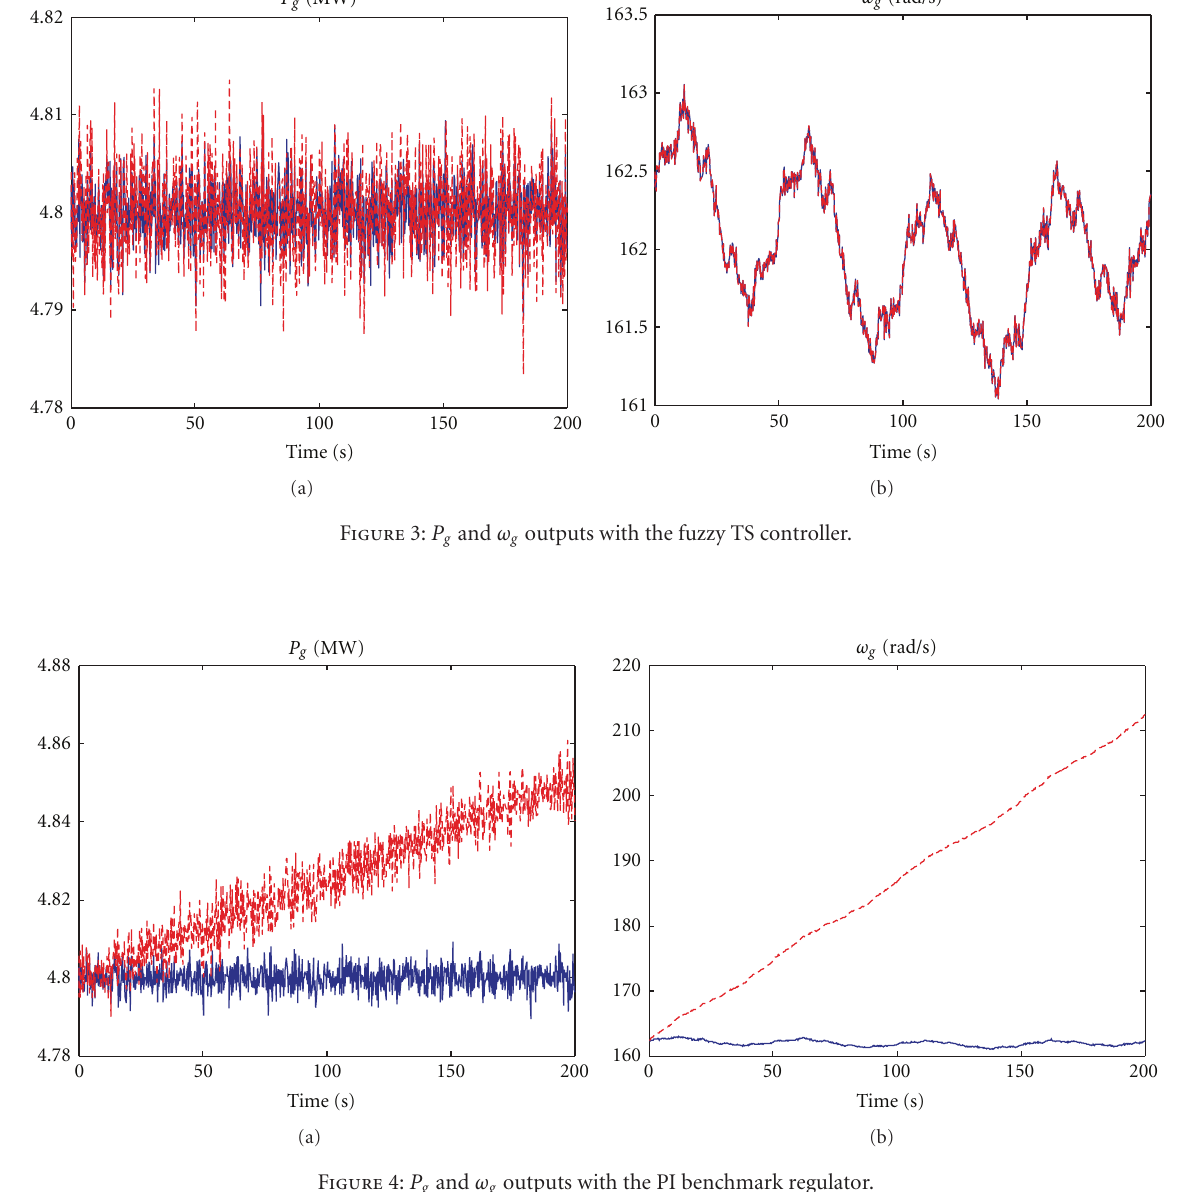
Figure 4: P g and ω g outputs with the PI benchmark